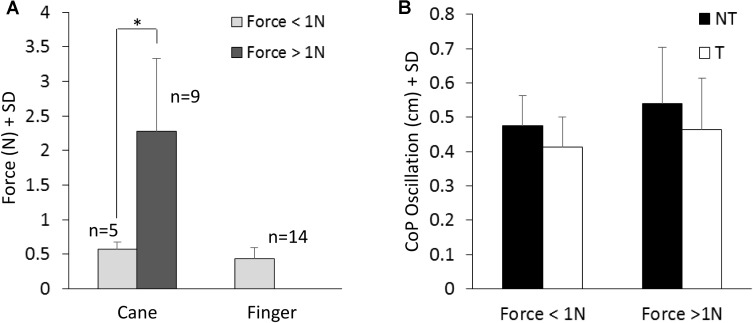
(A) Mean value of force exerted by cane or finger during the touch period. The dark column refers to the subjects that exerted more than 1N force. (B) Shows the mean M-L CoP oscillations in the two sub-group of subjects (A) standing with the cane during NT (black bars) and T (white bars) periods. The oscillations during T (cane) are not related to the level of force exerted onto the ground.